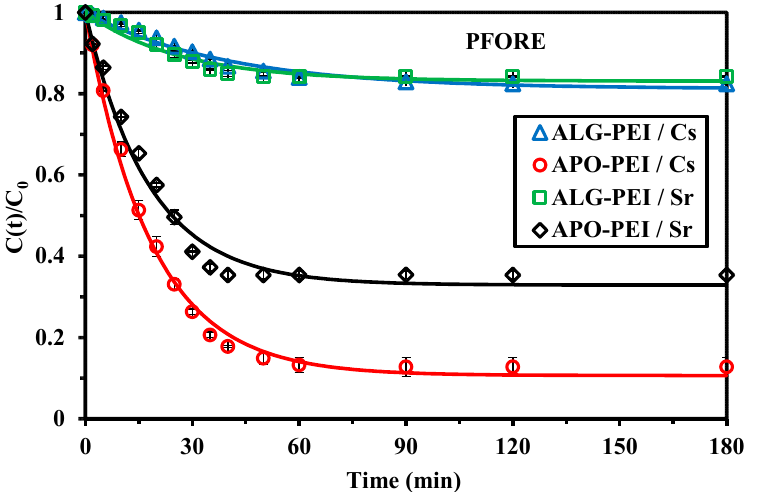
Figure 3. Uptake kinetics for Cs(I) and Sr(II) sorption using ALG-PEI and APO-PEI sorbents (C 0 : 0.760 mmol Cs L − 1 or 1.188 mmol Sr L − 1 ; sorbent dose, SD: 0.67 g L − 1 ; v: 210 rpm; pH 0 : 7; T: 21 ± 1 ◦